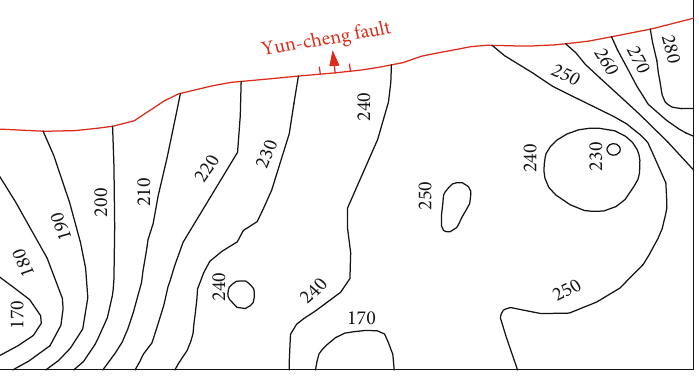
Figure 3: Quaternary contour map.